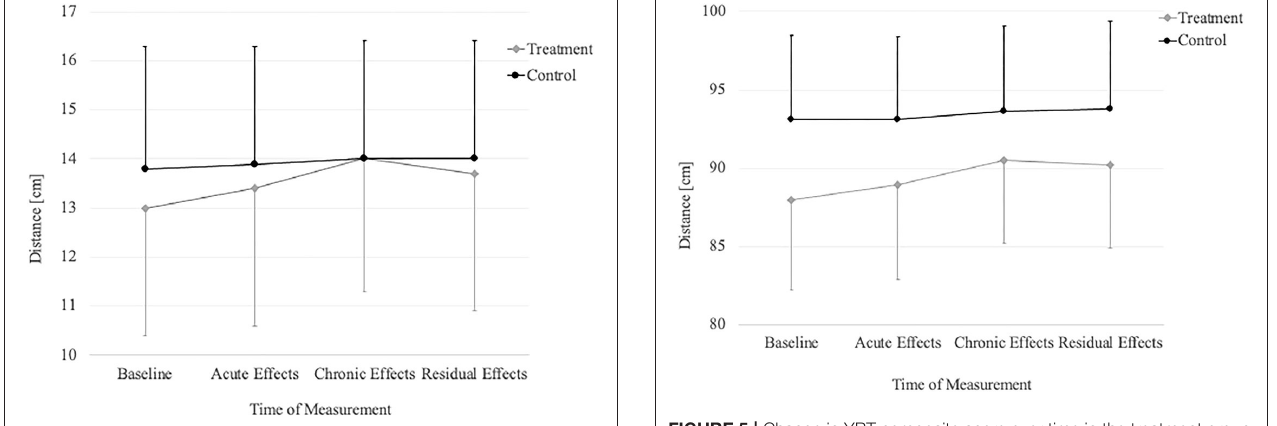
FIGURE 5 | Change in YBT composite score over time in the treatment group and